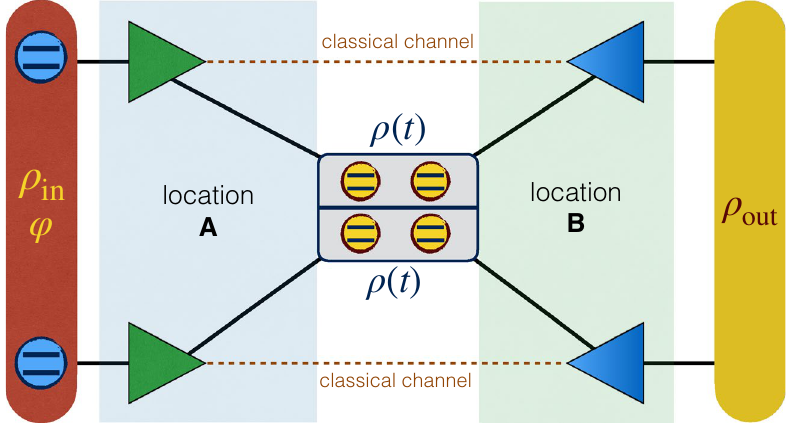
Figure 5. Sketch of the noisy two-qubit teleportation protocol. Two copies of the evolved noisy two-qubit state ρ( t ) are employed as resource channel for the protocol, shared between the two locations A and B. The input state ρ in to be teleported, containing information about the phase parameter ϕ , is manipulated in location A. After the protocol, the state ρ out is teleported at the location B encoded in the two qubits coming from the resource state 42 . This figure was created using Keynote, version 10.3.9 (7029.9.8), URL: https:// apps. apple. com/ it/ app/ keyno te/ id409 183694? mt=